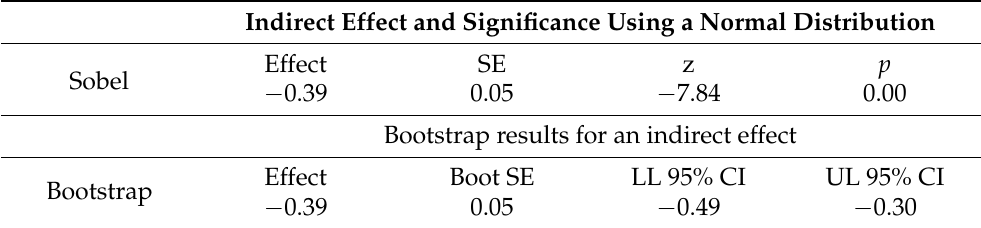
Table 4. Indirect Effect of Mastery Climate on Knowledge Hiding (T2) Through Work Alienation. Indirect Effect and Significance Using a Normal